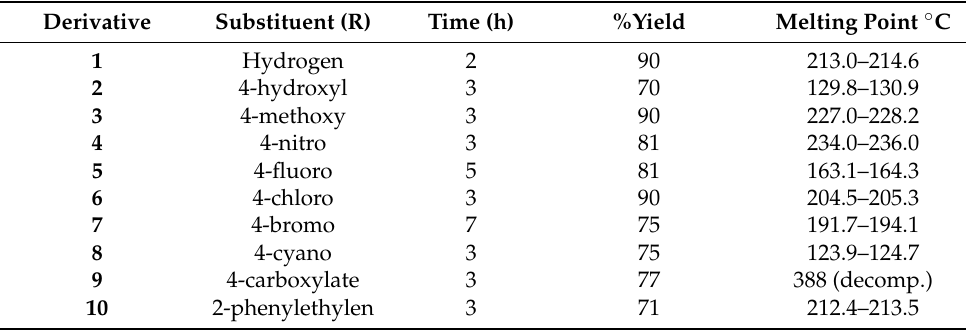
Figure 1. Reagents and conditions for DDS imine derivatives synthesis. Derivatives 2 , 3 , 5 , 7 , 8 , and 10 were obtained as monosubstituted compounds. Derivatives 1 , 4 , 6 , and 9 were obtained as N , N (cid:48) -substituted compounds. Table 1. Summary of DDS imine derivatives